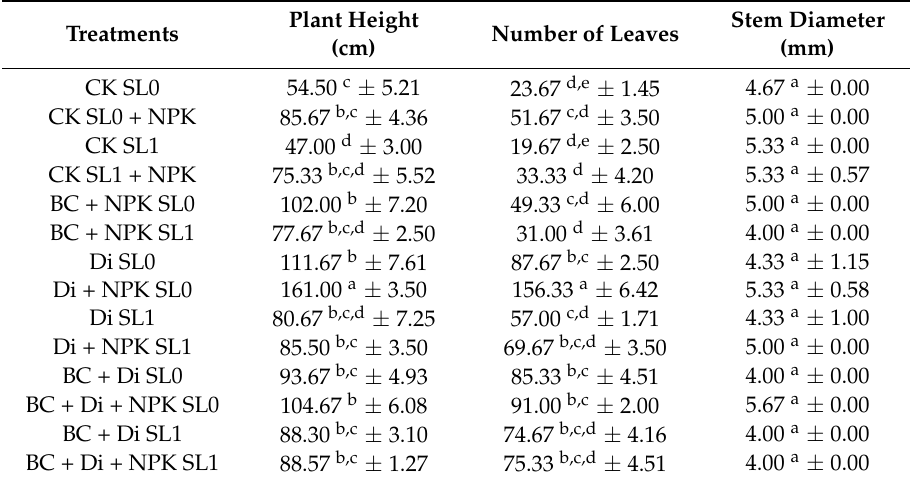
Table 7. Mean ( ± Standard deviation) growth parameters of melon plants at the fruit stage.